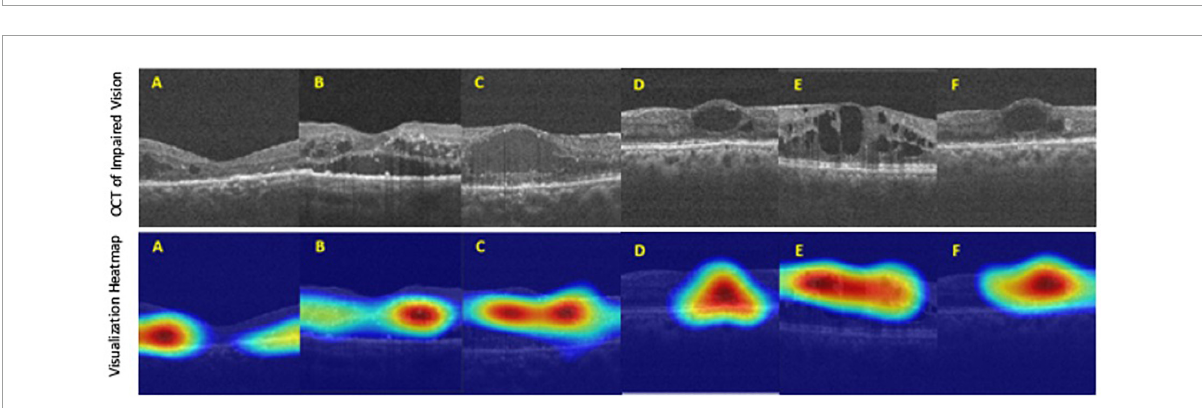
FIGURE6 The heat map visualization of representative six (A–F) OCT images recognized by our AI model as predictors of best-corrected visual acuity (BCVA)-defined impaired vision. Top panel : original input images from the final test dataset. Bottom panel : heat map visualization of areas used by our AI model to discriminate between BCVA